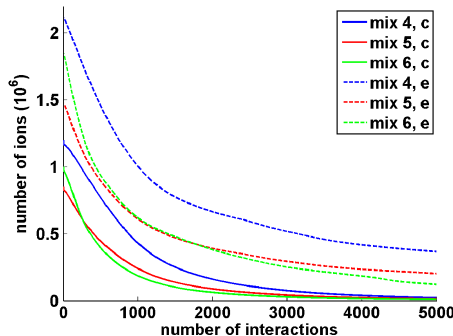
FIG. 7. Clearing times of ion clouds with different composi- tions in a circular (solid lines) and elliptical (dashed lines) beam pipe. 2000 bunch-interactions correspond to a clearing time of about 1 . 5 μ s.